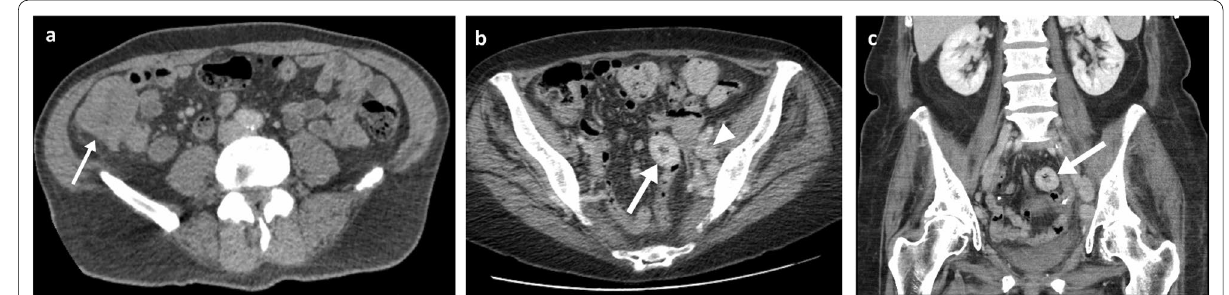
Fig. 9 Colonic melanoma metastases. Portal phase contrast-enhanced CT axial ( a ) of a 71-year-old male patient with a caecal pole melanoma metastasis (arrow). Portal phase contrast-enhanced CT axial ( b ) and coronal ( c ) of 71-year-old female patient with a melanoma metastatic deposit to the sigmoid colon with circumferential thickening and enhancement (arrows) and pathological left iliac nodes (arrowhead)